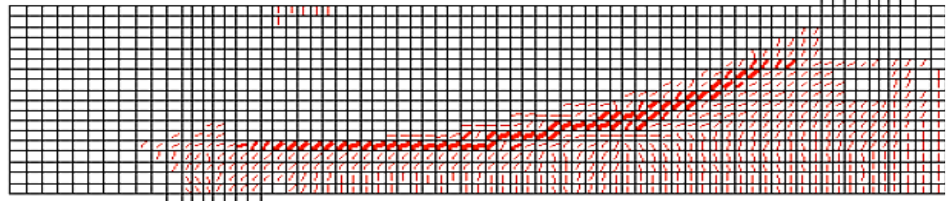
Figure 19. Mode of Failure of Specimens CON-S0, CON-S1, and CON-S3.